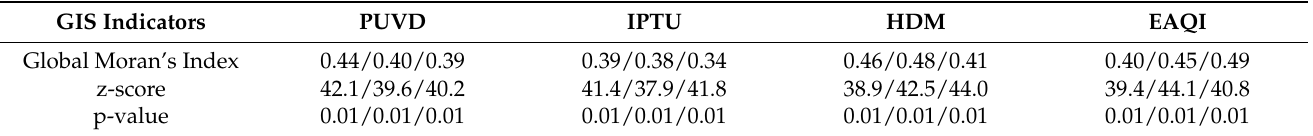
Table 1. Global Moran’s I statistic for urban mobility and air quality indicators before and during the COVID-19 pandemic (data order: 2019/2020/2021).